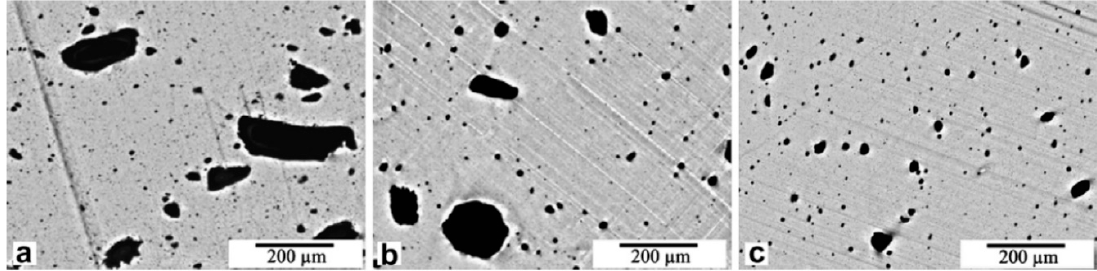
Figure 17. Optical micrographs of polycarbonate with 1 wt% MWCNT (Baytubes C150HP) where the polycarbonate differs in melt viscosity: ( a ) low (Makrolon2205), ( b ) medium (Makrolon 2600), and ( c ) high (Makrolon 3108) melt viscosity [70].